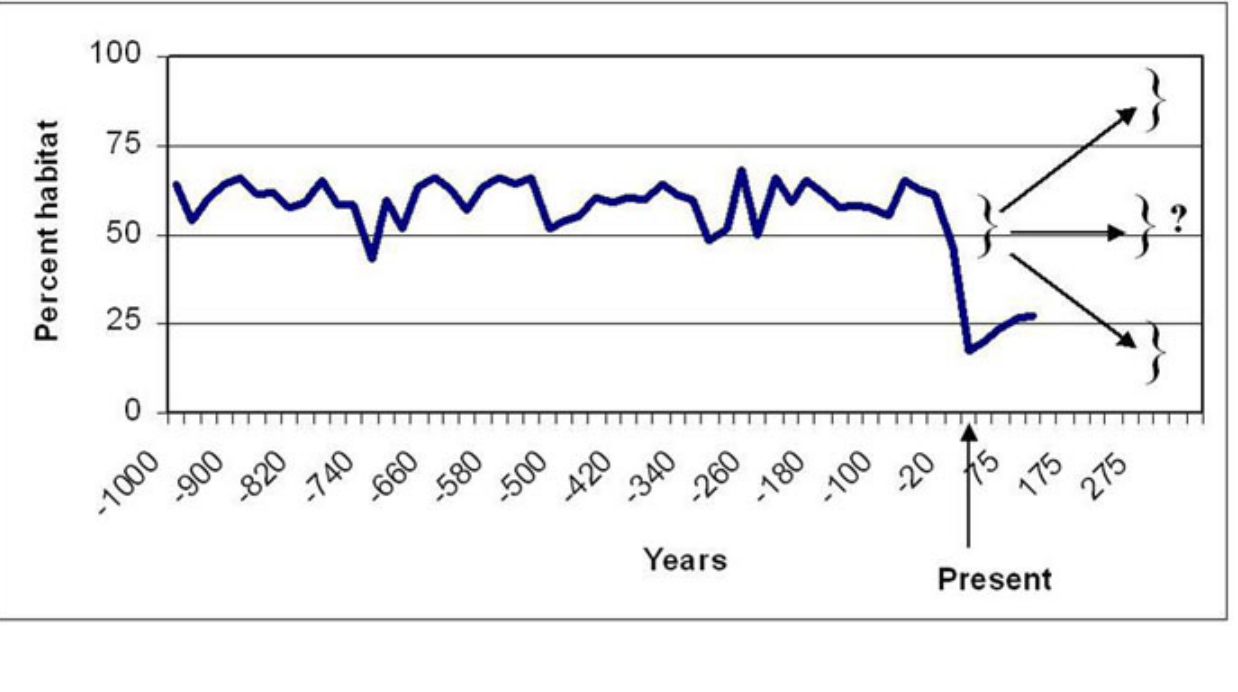
Fig. 5. Estimated changes in a pileated woodpecker habitat availability under historic conditions (time < 0, based on Wimberly 2002) and future conditions (time > 0) compared to cultural range of acceptability (brackets) at present and into the